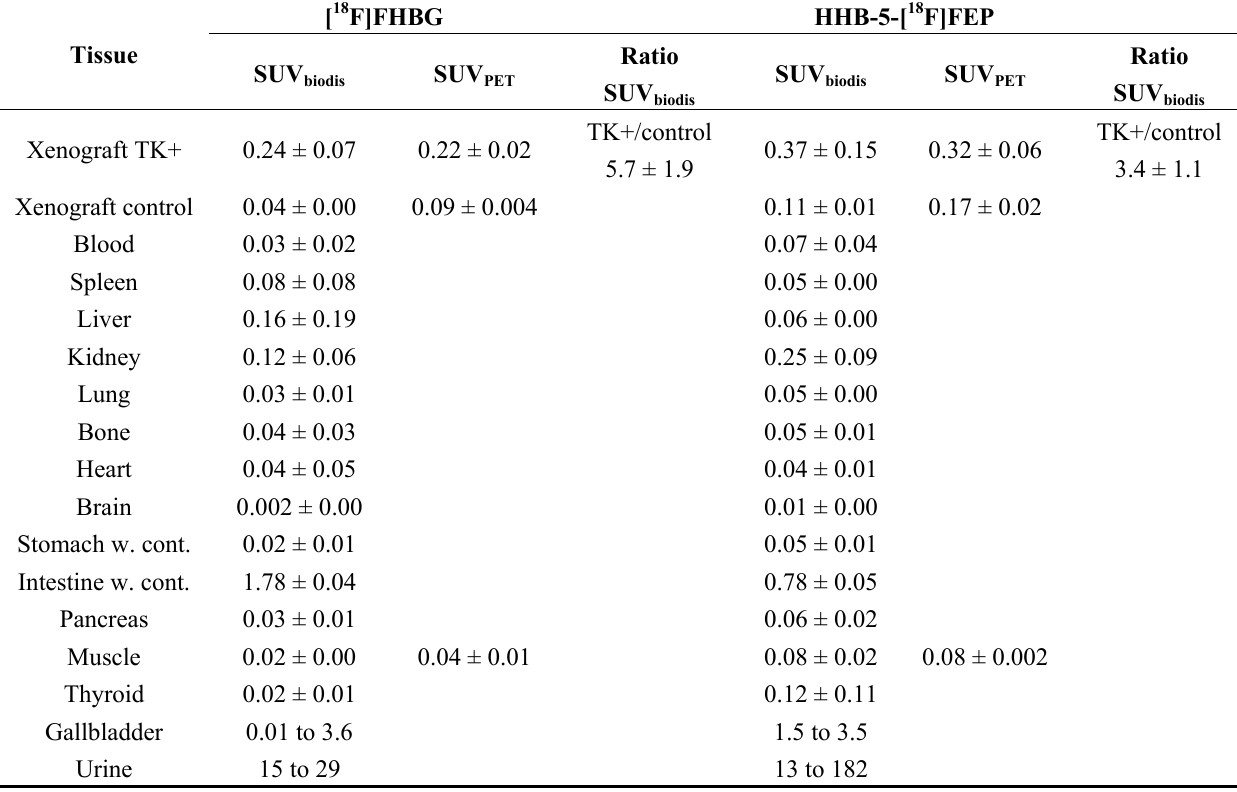
) and PET data (SUV biodis